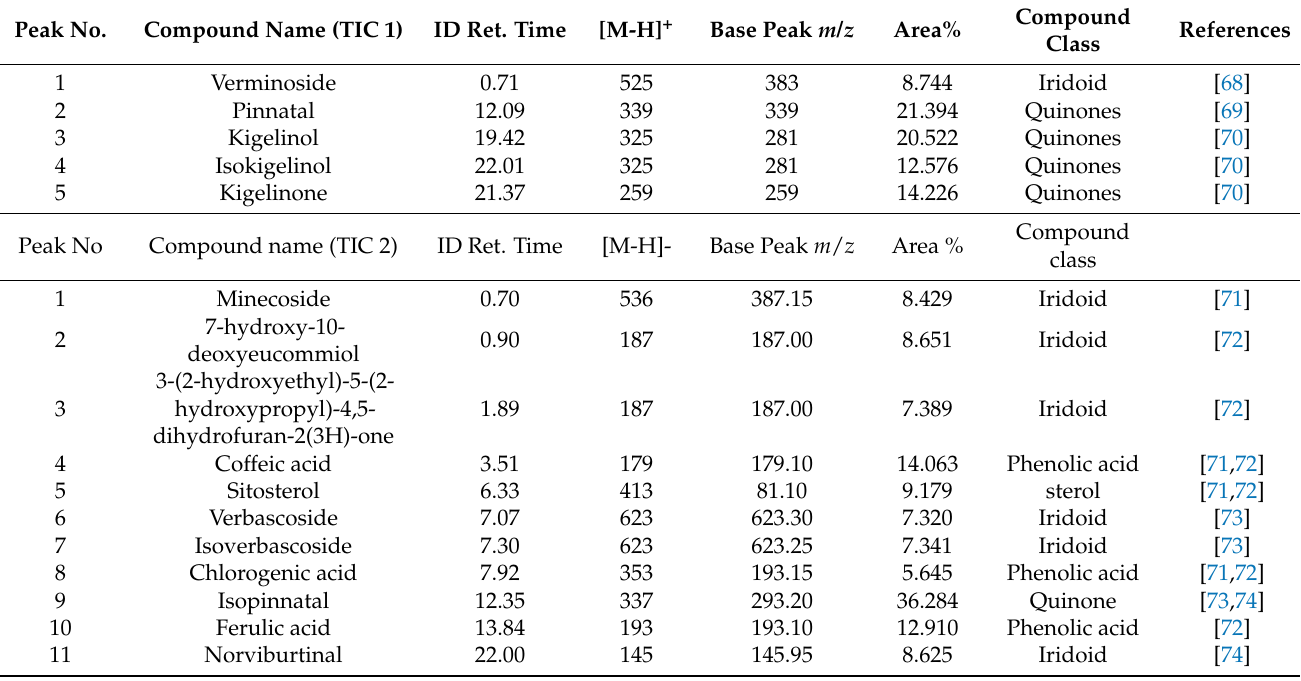
Table 8. Phytochemical compounds identified by LC-MS/MS in crude methanolic extracts of ma- ture (K m ) fruits of K. pinnata in positive (TIC 1) and negative (TIC2) ion modes.